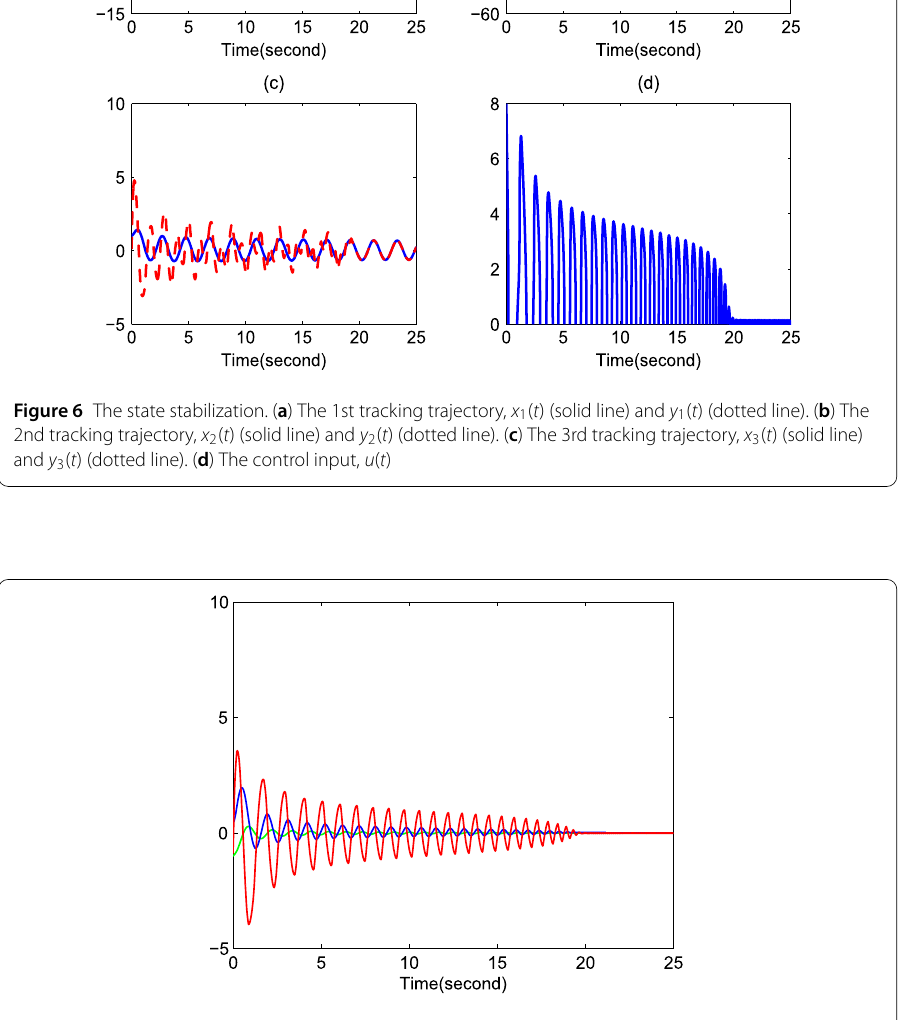
Choose k 11 = k 12 = 1.2, k 13 = 1, k 21 = k 22 = 0.5, k 23 = 0.8, k 31 = k 32 = k 33 = 2, ξ 1 = ξ 2 = ξ 3 = ˆ ξ ˆ ξ ˆ ξ 10, and 1 = 2 = 3 = 0.05 as the parameters of the controller. Set the external disturbances d 1 ( t ) = sin (10 t ), d 2 ( t ) = 0.1 + cos ( t ), and d 3 ( t ) = 0.1 + sin (5 t ), respectively. Figures 6 and 7 depict the state stabilization and the state synchronization under simulation, respectively. This indicates that the simulation results coincide with those of the preceding theoretical